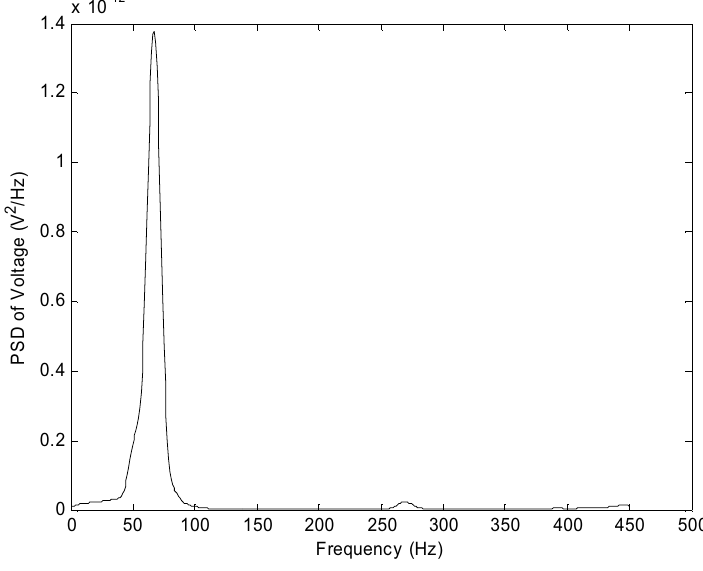
Fig. 16. Frequency spectrum of the PZT sensor voltage of Fig. 15.